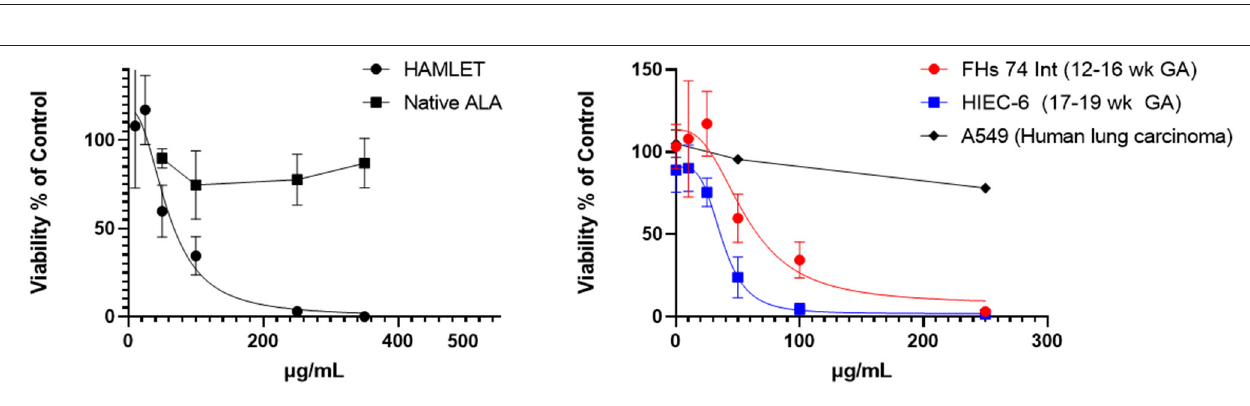
FIGURE 6 | HAMLET vs. α -lactalbumin cytotoxicity in fetal intestinal cells. Left: Comparison of HAMLET with native substrate alpha-lactalbumin. Right: Comparison of 2 non-transformed fetal epithelial intestinal cell lines (Fhs 74, HIEC-6) and a lung carcinoma cell line (A549) with increasing concentrations of HAMLET. The estimated lethal dose of HAMLET to kill 50% of cells in culture (LD50) is 56.9 (34.1–79.4) µ g/mL for FHs 74 Int and HIEC-6 has an LD50 of 37.6 (30.97–44.2) µ g/mL. Viability was measured with MTT assay after 3.5h. Dotted lines are average curves plotted by GraphPad Prism 9. All data are presented as mean ± SD